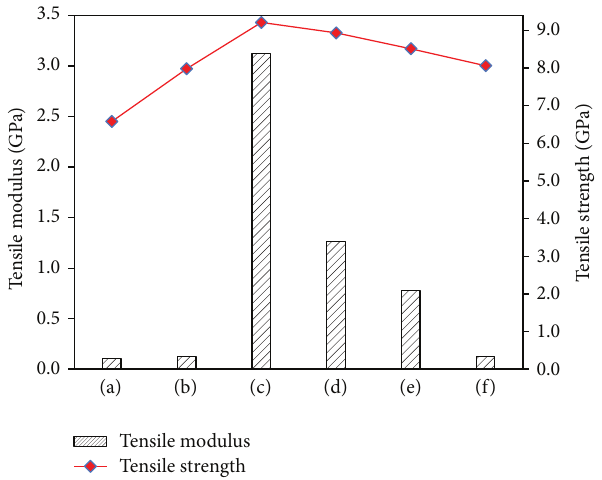
Figure 4: Tensile strength and modulus of (a) pure PLA, (b) PLA/FS, (c) 2wt% of PLA/FS/clay (1.28E) nanocomposite, (d) 5wt% of PLA/FS/clay (1.28E) nanocomposite, (e) 10wt% of PLA/FS/clay (1.28E) nanocomposite, and (f) 15wt% of PLA/FS/clay (1.28E) nanocomposite.